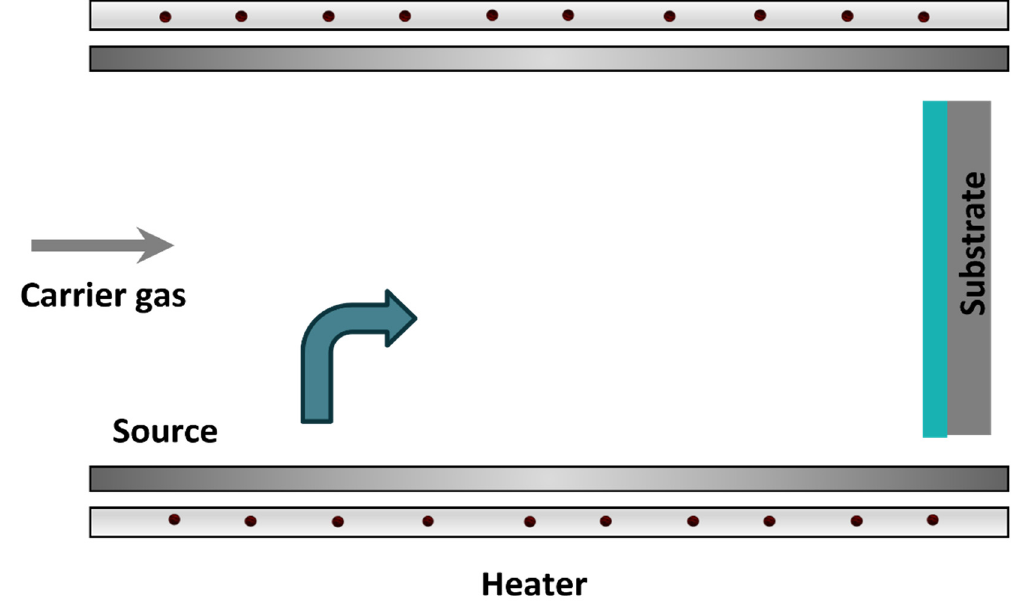
Figure 6. Organic vapor-phase deposition.